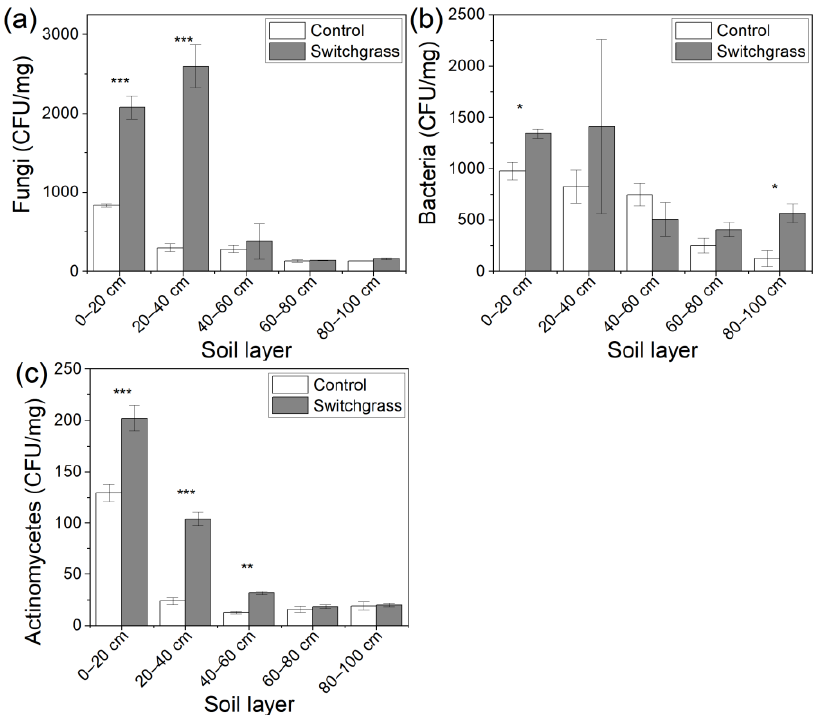
Figure 4. CFU numbers of ( a ) fungi, ( b ) bacteria, and ( c ) actinomycetes in the bare land and switchgrass-cultivated land. Error bars (standard deviation) were correctly added at the top of the mean columns. A Wilcoxon rank-sum test was used to analyze the significant differences between the bare land and switchgrass cultivated land at p < 0.05 (*), 0.01 (**), and 0.001 (***) levels. Soil MC, MN, and MP at all five soil depths showed an increase in switchgrass land compared to the bare land (Figure 5). The significant ( p < 0.001) increase percentages of soil MC in 0–40 cm soil in switchgrass land were large, reaching 117.42% and 57.58%, respectively, and at 40–100 cm soil depths, they reached 18.30%, 11.34%, and 37.87%, sequentially, when compared to the bare land (Figure 5a). For soil MN, the increase percentages reached 20.48% ( p > 0.05), 41.01% ( p < 0.05), 12.45% ( p > 0.05), 42.20% ( p < 0.05), and 11.45% ( p > 0.05), sequentially, in switchgrass land (Figure 5b). The significant ( p < 0.05 or 0.01) increases in soil MP mainly happened at 60–100 cm depths, and the increase percentages were 67.57% and 103.03%, sequentially; at the other soil depths, slight increases were observed (Figure